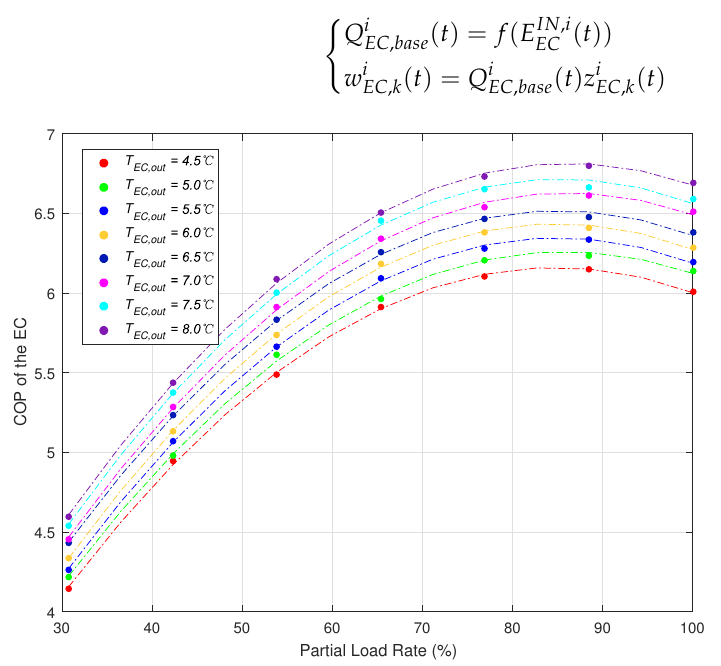
Figure 4. Diagram of the COP of the EC varied with the partial load rate under different outlet temperature setpoint T EC , out fitted by actual operating